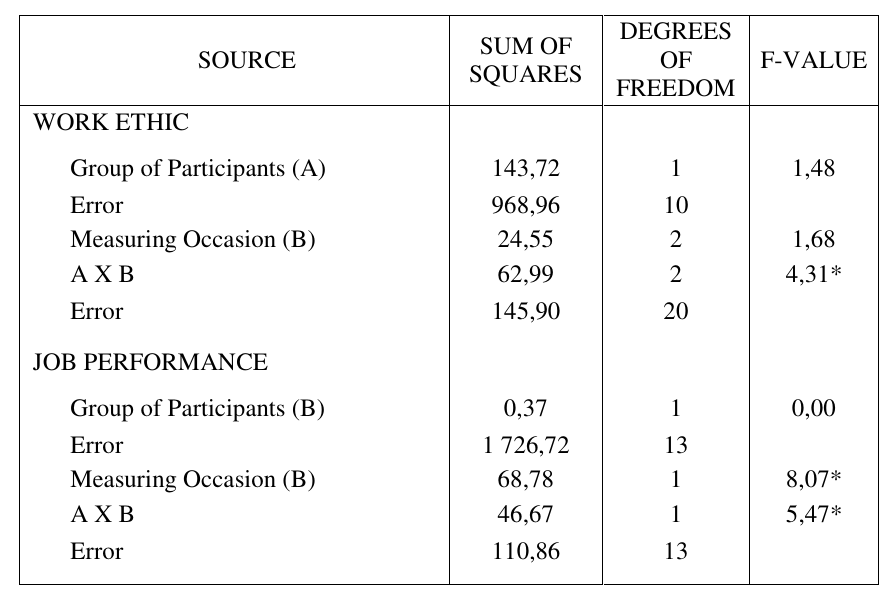
RESULTS OF THE ANALYSIS OF VARIANCE FOR THE WORK ETHIC AND JOB PERFORMANCE